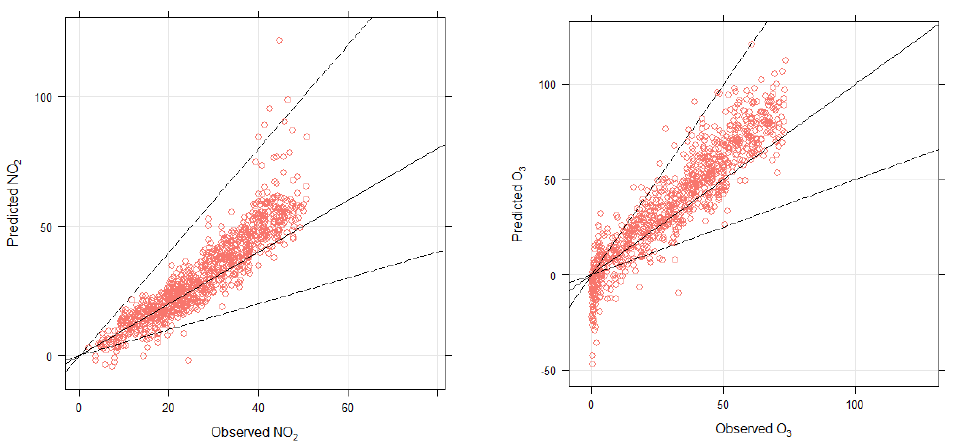
Table 5. Statistical metrics for cross-validated models using 25% of the randomly selected testing dataset. The values outside of the parenthesis are for quantile regression (QRM) and inside are for multiple linear regression model (MLRM).